Question: Summarize what this figure shows in one sentence.
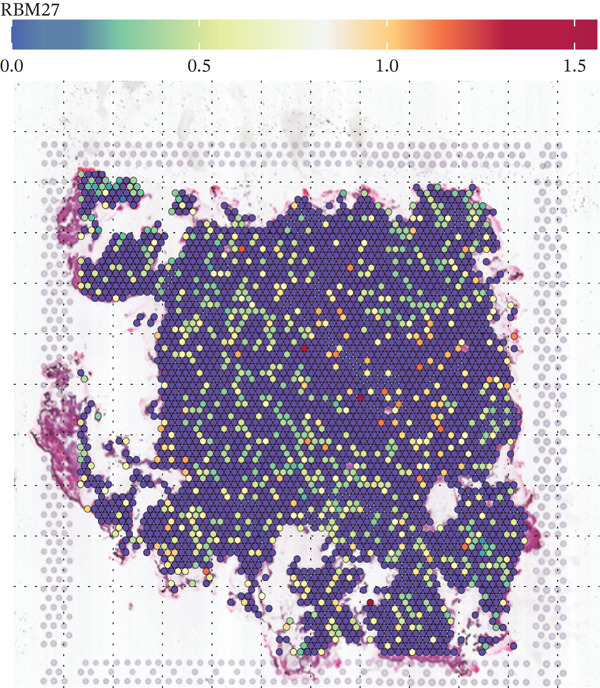
Answer: Spatial validation of RBM27‐malignant niche association and immune exclusion. (a, b, e, f, i, j, m, n) Spatial mapping of RBM27 enrichment within malignant regions across four HCC datasets. (c, g, k, o) Spearman′s correlation between cell content and cell content and between cell content and gene expression in all spots. (d, h, l, p) Quantitative comparison of RBM27 expression in tumor versus adjacent normal tissues. (q) Spatial correlation between RBM27 and proliferation‐associated genes (PCNA, Ki67, CENPF, and TOP2A).